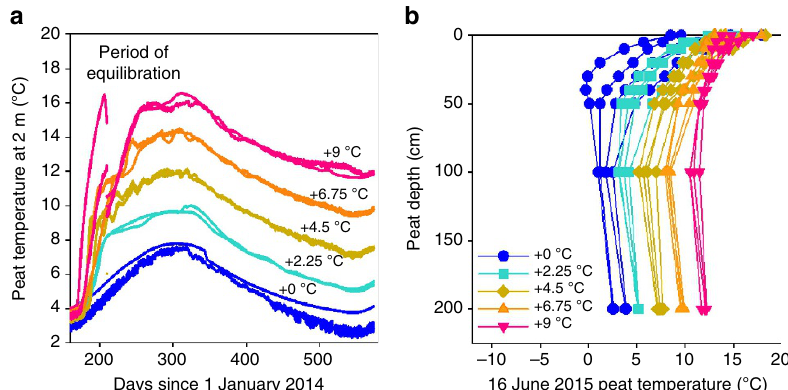
Figure 2 | Peat temperatures throughout DPH treatment period. The seasonal progress of ( a ) absolute peat temperatures at 2m below the hollow surface throughout the DPH treatment period and ( b ) the temperature depth profiles associated with the 16 June 2015 coring event. This coring event took place 10 months after the deep peat temperature differentials were stable. In a , blue denotes control ( þ 0 (cid:2) C) plots, green denotes þ 2.25 (cid:2) C plots, gold denotes þ 4.5 (cid:2) C plots, orange denotes þ 6.75 (cid:2) C plots, and red denotes þ 9 (cid:2) C plots. In b , circles denote control ( þ 0 (cid:2) C) plots, squares denote þ 2.25 (cid:2) C plots, diamonds denote þ 4.5 (cid:2) C plots, triangles denote þ 6.75 (cid:2) C plots and inverted triangles denote þ 9 (cid:2) C plots. In the absence of air warming during this phase of the experiment, anticipated energy loss reduced the separation among treatment temperatures at the